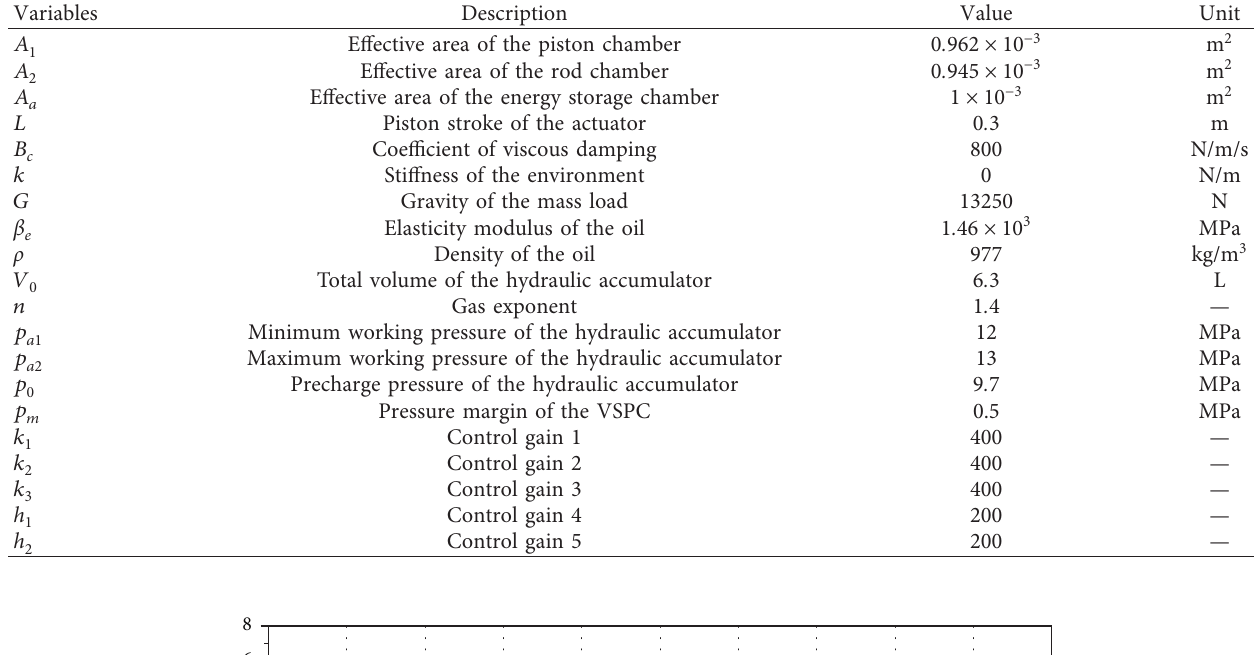
Figure 6: Model of the entire system. Table 3: Parameters of the system.